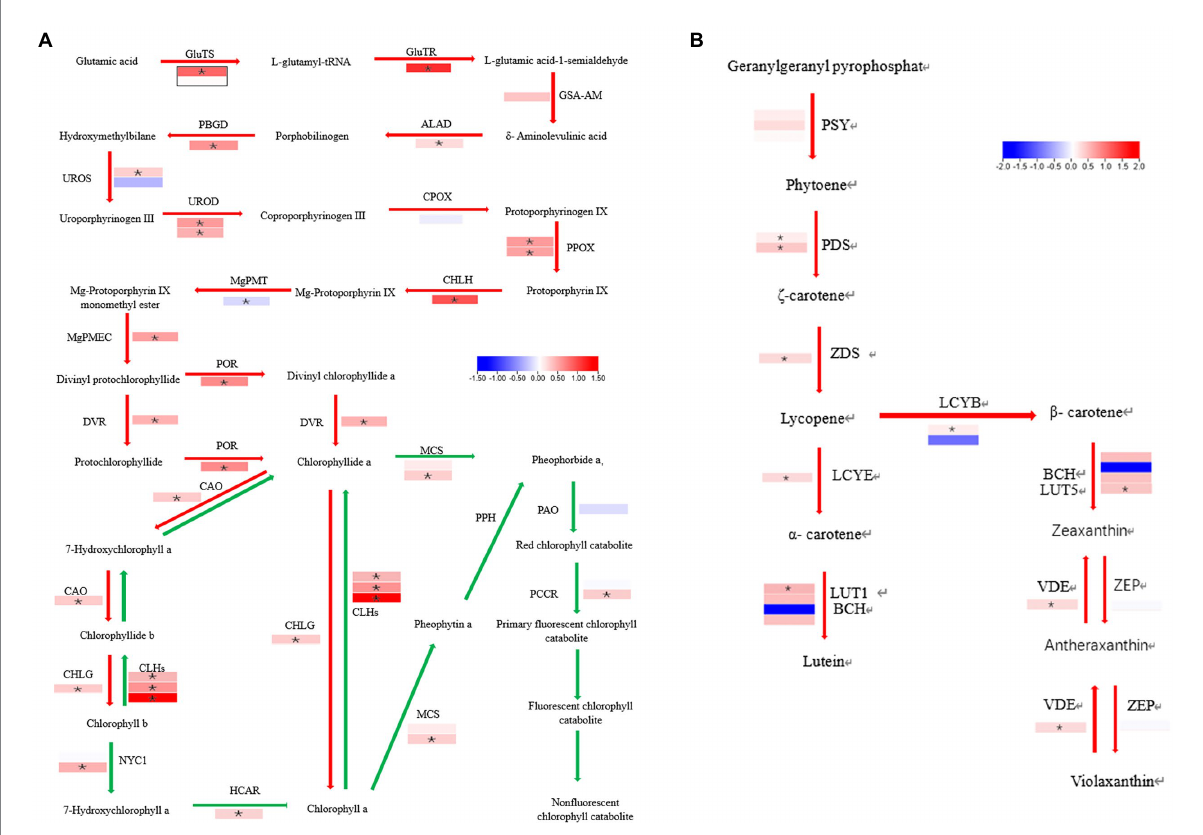
FIGURE 9 Difference in the enzyme expression between the WT and v-3 in the chlorophyll and carotenoid biosynthetic pathways. (A) The red arrow represents the chlorophyll synthesis pathway, and the green arrow represents the chlorophyll decomposition pathway. (B) Carotenoid biosynthesis pathway. In mutants, the upregulated gene is in red boxes, and the downregulated gene is in blue boxes. The white boxes represent genes with unchanged expression. *DEGs with | FoldChange| > 1.5 and p < 0.05. DEGs, differentially expressed genes; WT, wild